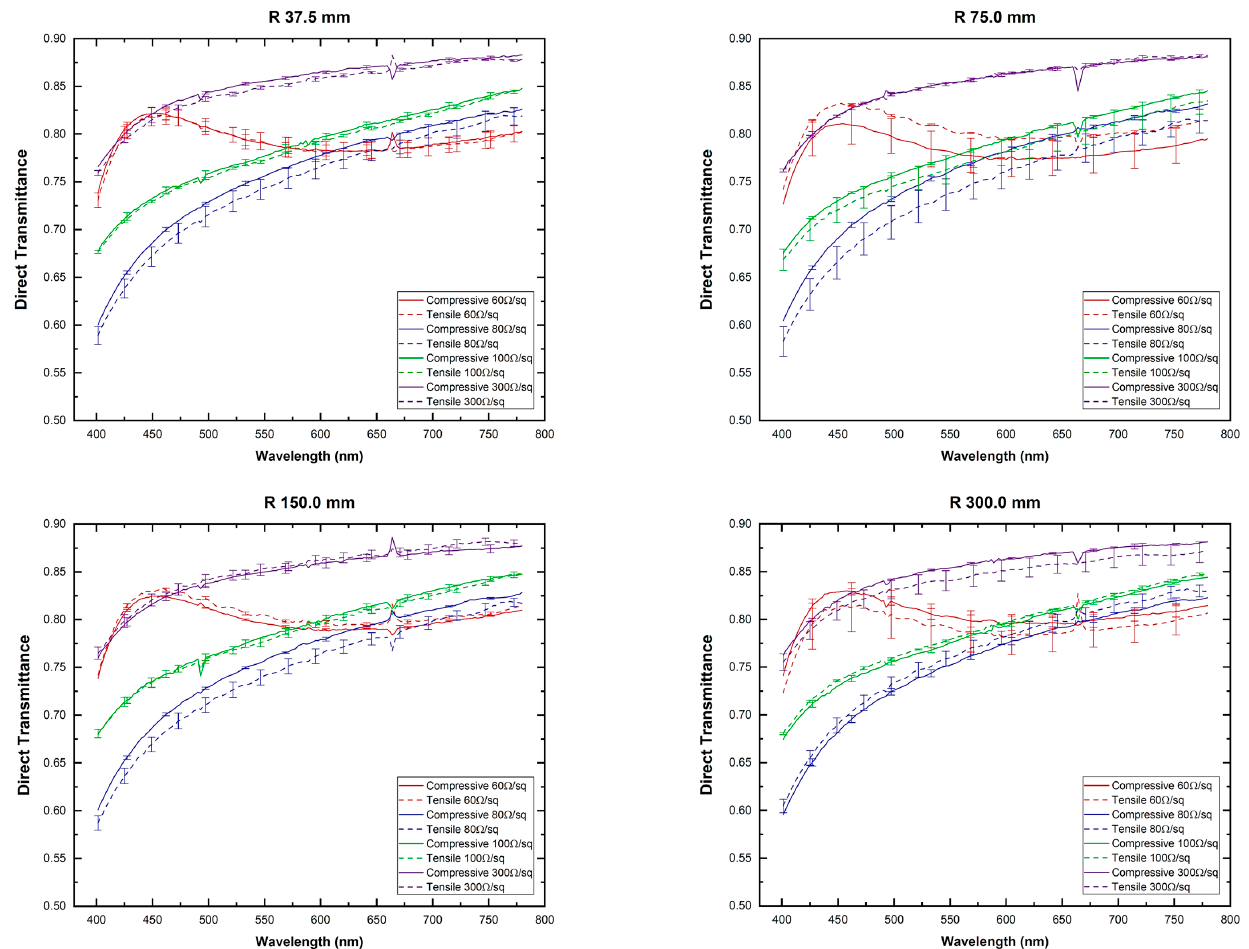
Figure 6. Direct transmittance was measured for different ITO-PET samples and four radii of curvature.